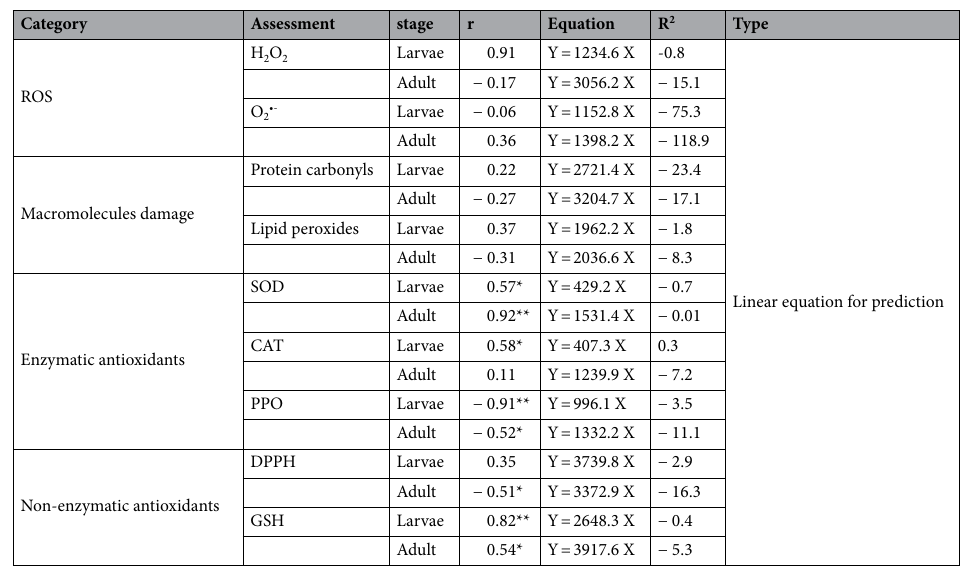
Table 2. Pearson ′ s correlation coefficient to detect the effect of malathion different concentration (0, 0.005, 0.01, 0.015, and 0.02 mg/ml) on reactive oxygen species concentration (ROS), (in form of hydrogen peroxide (H 2 O 2 ), superoxide anion radical (O 2 •- )), macromolecules damage (in form of protein carbonyls amount and lipid peroxides concentration), enzymatic antioxidant response (inform of superoxide dismutase (SOD), catalase (CAT), and polyphenol oxidase (PPO)), and non-enzymatic antioxidant response (inform of anti-radical 2,2-diphenyl-1-picrylhydrazyl (DPPH) and antioxidant glutathione reduced (GSH)) in the gut homogenates of 5th instar larvae and males of Hermetia illucens . * significant at p < 0.05 ; ** significant at p < 0.001